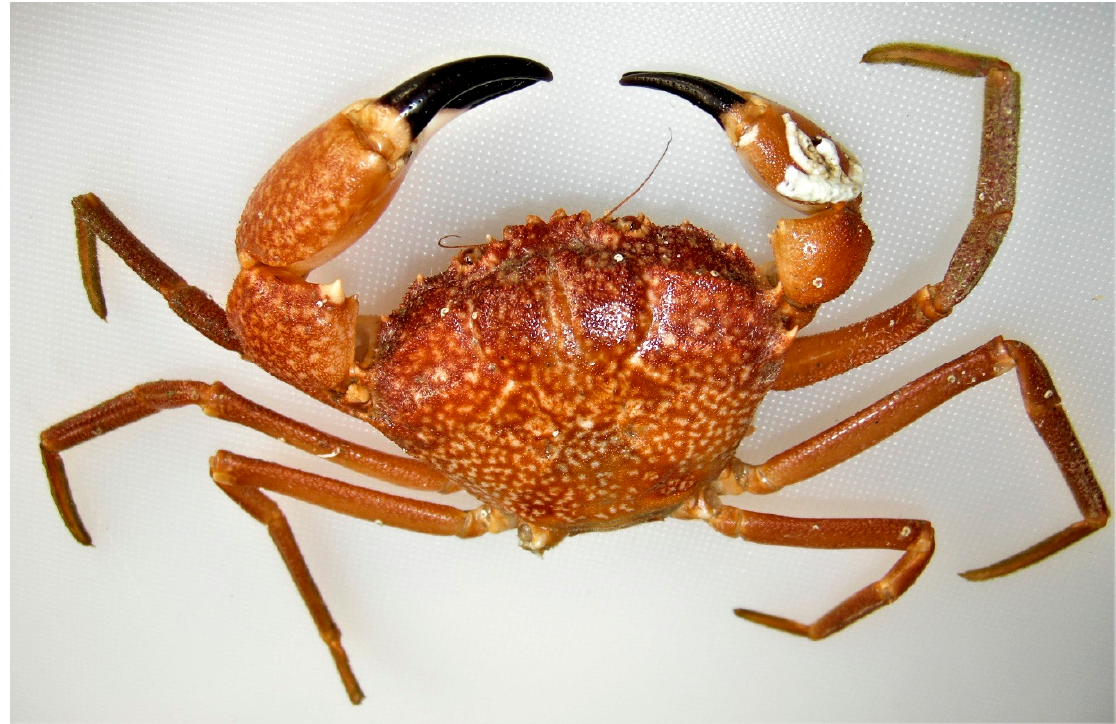
Figure 1. Male Paragalene longicrura (Nardo, 1868) from the Thermaikos Gulf, northwest Aegean Sea, Greece. Carapace length (CL) 37.47 mm, carapace width (CW) 45.73 mm.